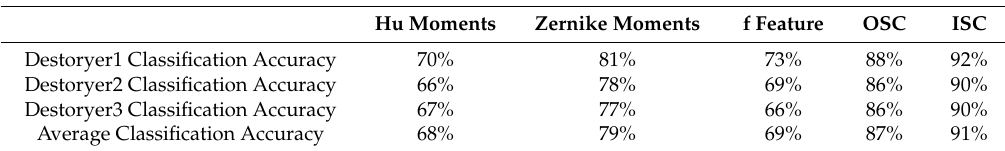
Table 1. Comparison of Classification Accuracy obtained by Hu moments, Zernike moments, f feature, OSC (Original Shape Contexts) and ISC (Improved Shape Contexts).